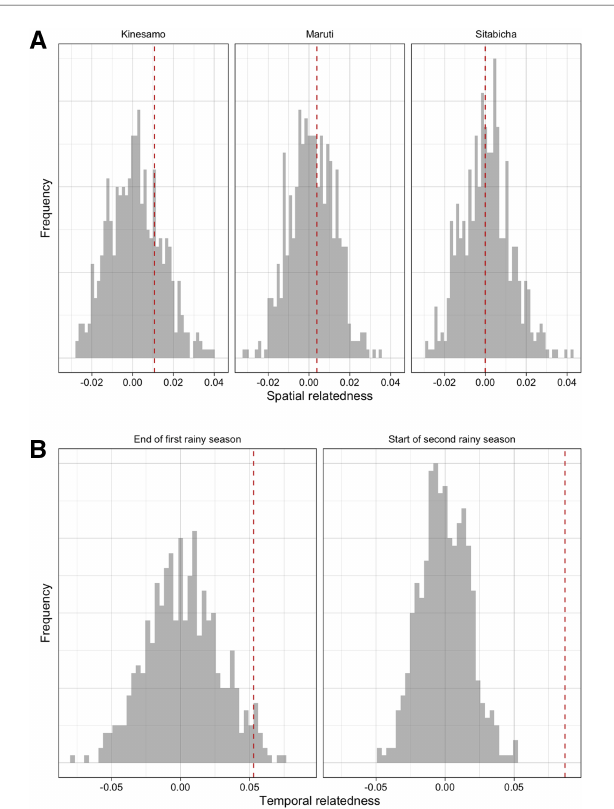
FIGURE 2 The overall patterns of differentiation across space and time amongst samples from the cohort data. ( A ) Spatial relatedness in cohort data in each village (difference in mean relatedness in pairs of infections where both are from the speci fi ed village and pairs where only one is from that village). ( B ) Temporal relatedness (difference in mean relatedness in pairs of infections where both are from the same time period and pairs from different time periods) when considering the end of the fi rst rainy season and start of the second rainy season. In both panels, the value observed in the data (red dashed line) is compared to a null distribution where there is no village or temporal structure, respectively (grey